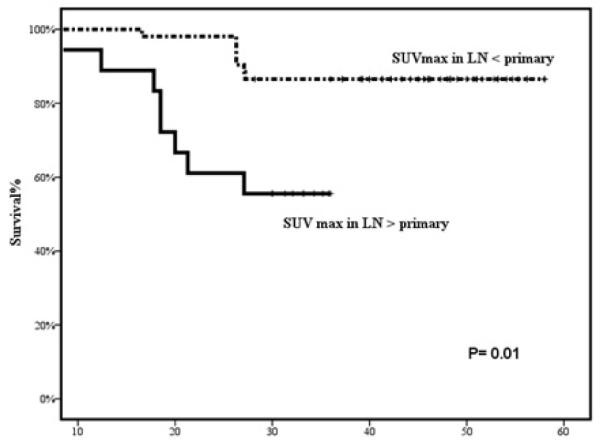
Progression free Survival in months.